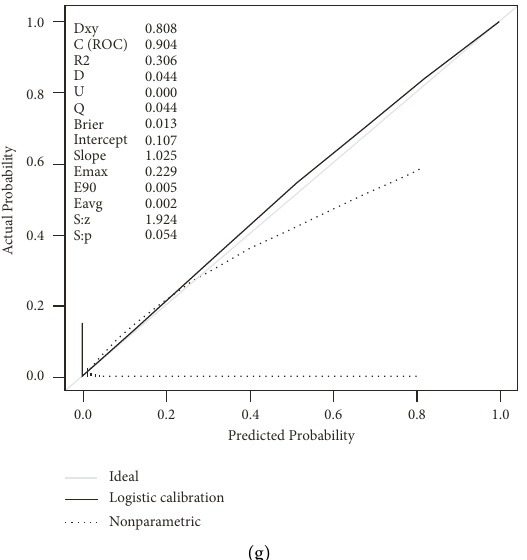
Figure 1: Construction of a nomogram capable of predicting prostate cancer patient bone metastasis. (a) Forest plot results corresponding to a univariate logistic regression model analysis of bone metastasis risk. (b) Forest plot results corresponding to a multivariate logistic regression model analysis of bone metastasis risk. The x -axis corresponds to the OR for bone metastasis. OR: odds ratio. CI: confidence interval. (c) A nomogram used to predict the odds of prostate cancer patient bone metastasis based on patient age, T_stage, N_stage, PSA, primary Gleason score, and secondary Gleason score. To use the nomogram, a straight line was drawn upwards from the appropriate point on each variable axis to the score axis, with the points for each of these predictors being summed together. The total sum score was then used to judge the odds of bone metastasis for that patient by drawing a line downwards. (d) ROC curves for the predictive nomogram in the training cohort (ROC curve AUC � 0.9; cutoff � 0.016; sensitivity � 0.864; specificity � 0.788). (e) ROC curves for the predictive nomogram in the validation cohort (ROC curve AUC � 0.904; cutoff � 0.016; sensitivity � 0.864; specificity � 0.812). (f) Calibration models for the predictive model when used to analyze the training cohort, with the actual and predicted probability being graphed against one another. (g) Calibration models for the predictive model when used to analyze the validation cohort. In the calibration curves, the reference line corresponds to perfect concordance between predicted and actual odds of bone